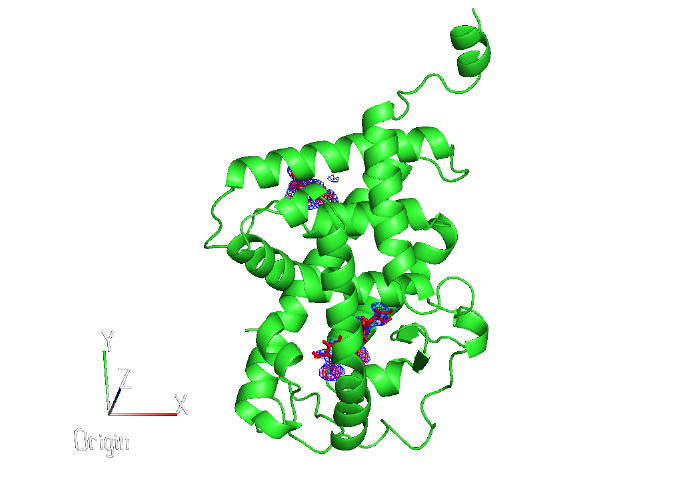
Figure 7. The two ligands and the reconstructed model of the test structure.